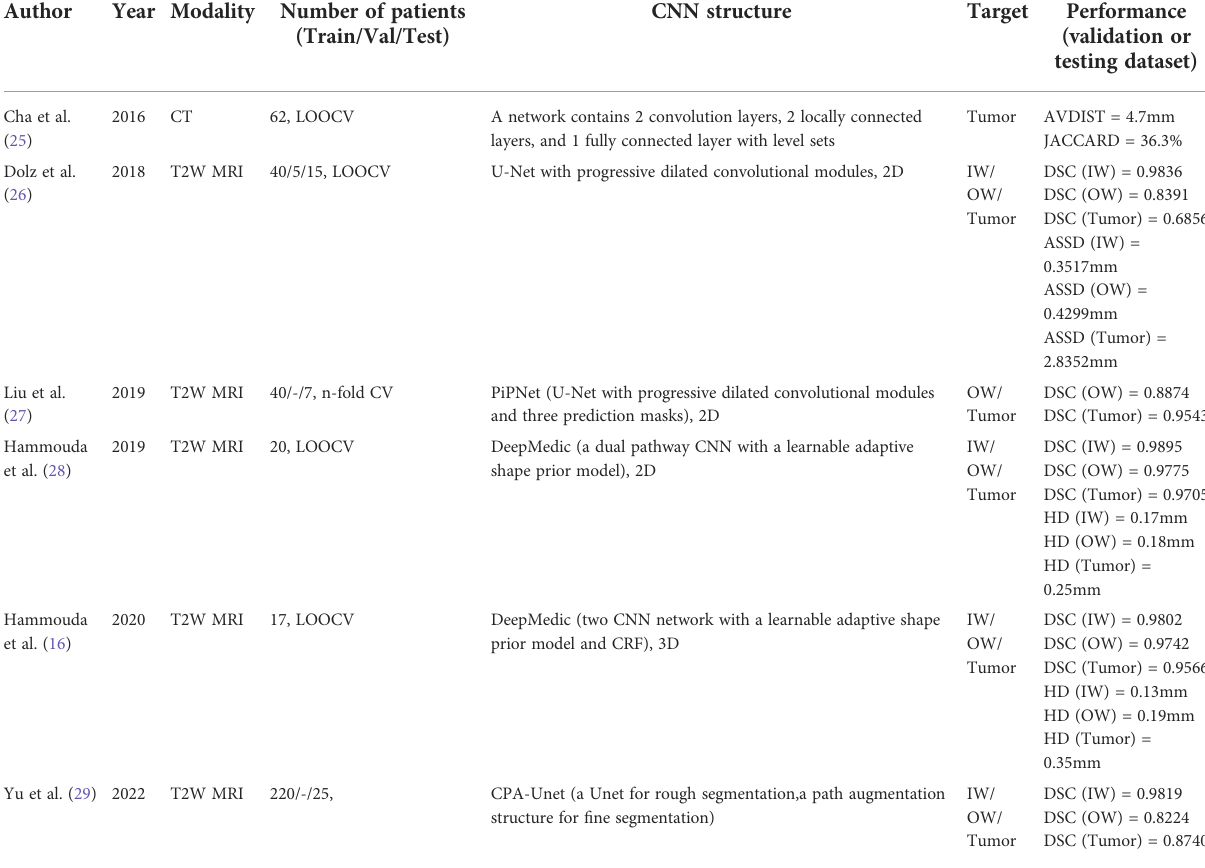
TABLE 1 Studies using deep learning approach for bladder cancer